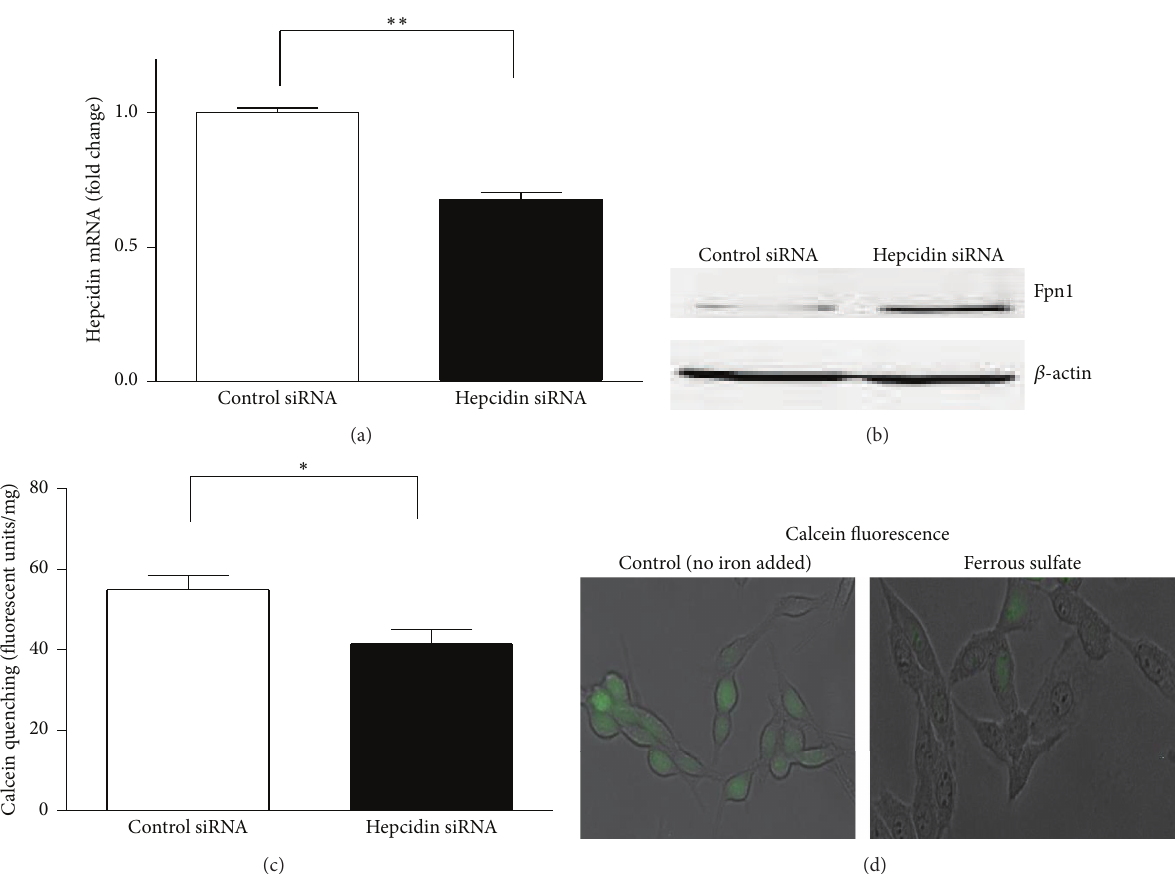
Figure 1: Effect of hepcidin knockdown on hepcidin mRNA levels measured by quantitative real-time RT-PCR ((a), 𝑛 = 7 -8), ferroportin 1 protein levels (normalized to 𝛽 -actin) measured by Western blot (b), and intracellular iron measured by a calcein quenching method ((c), 𝑛 = 6 ) in N27 cells. Representative calcein fluorescence images with and without incubation of 1mM ferrous sulfate for 30 min are shown (d). Values are mean ± SEM. Differences between two groups were based on Student’s 𝑡 -test; ∗ 𝑃 < 0.05 ; ∗∗ 𝑃 < 0.0001 . Control siRNA: scrambled small interfering RNA; hepcidin siRNA: hepcidin small interfering RNA; Fpn1: ferroportin 1. Table 1: The role of hepcidin knockdown in 6-OHDA induced oxidative damage measured by protein carbonyls ( 𝑛 = 4 ) and intracellular iron measured by calcein quenching method ( 𝑛 = 6 ). Protein carbonyls (nmol/mg protein) Calcein quenching (fluorescent units/mg protein) Control siRNA 112.4 ± 4.8 Hepcidin siRNA 8.9 ± 1.1 ∗ 80.8 ± 6.2 ∗∗ Values are mean ± SEM; ∗ 𝑃 < 0.05 ; ∗∗ 𝑃 < 0.01 . Differences between two groups were based on Student’s 𝑡 -test; control siRNA: scrambled small interfering RNA; hepcidin siRNA: hepcidin small interfering